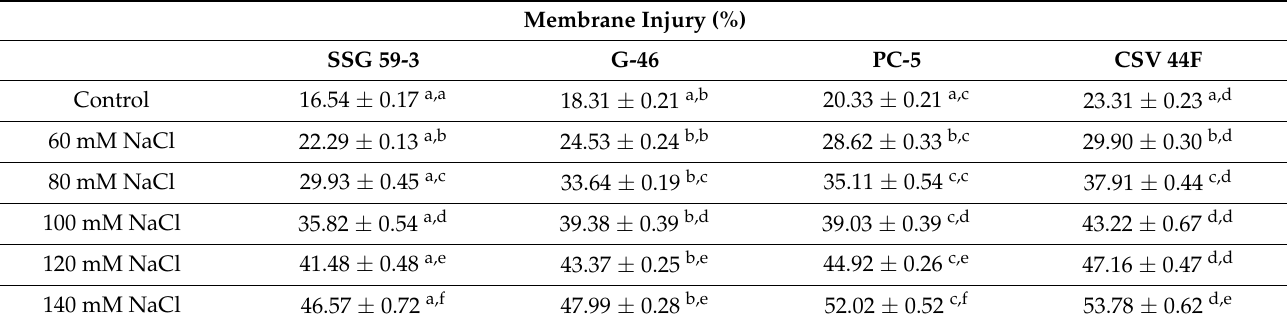
Table 5. Membrane injury in sorghum seedlings under salt